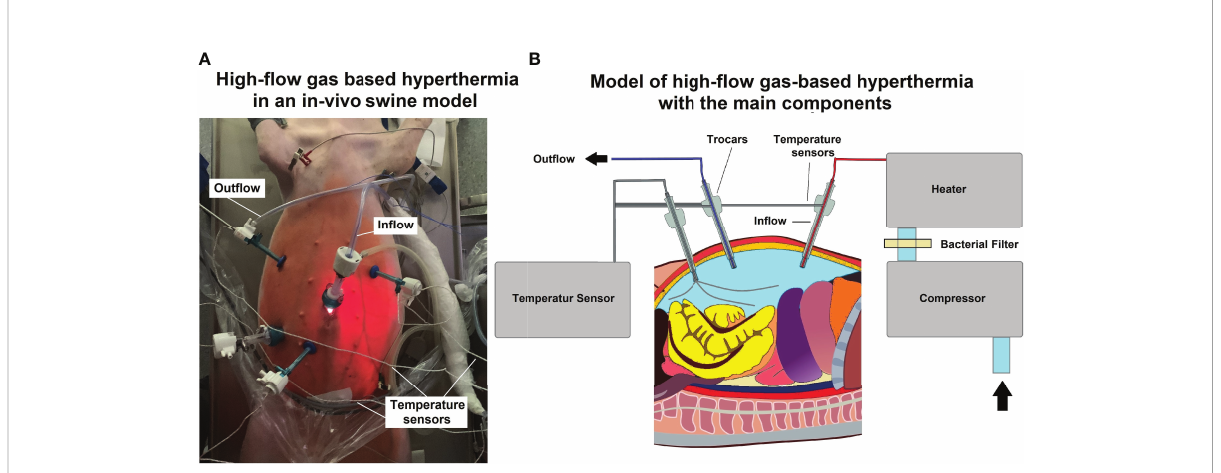
FIGURE 1 (A) Laparoscopy in the in vivo swine during high- fl ow gas-based hyperthermia. Multiple placements of temperature-sensors for intraoperative monitoring (B) Technical model of high- fl ow gas-based